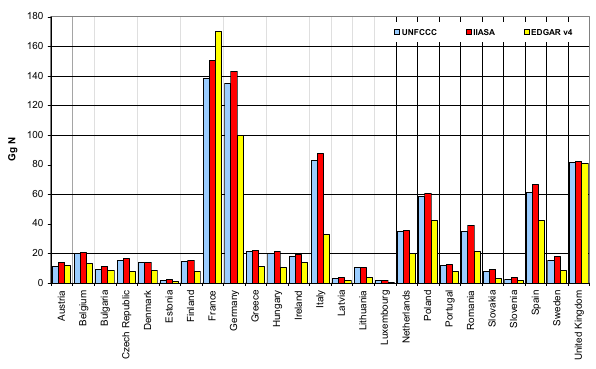
Fig. 3. Comparison of EU27 (not showing Malta and Cyprus) emissions of N 2 O (expressed as Gg N) reported to UNFCCC (without LULUCF, UNFCCC, 2009) and presented in the EDGAR v4 database (EDGAR, 2009) for the year 2005